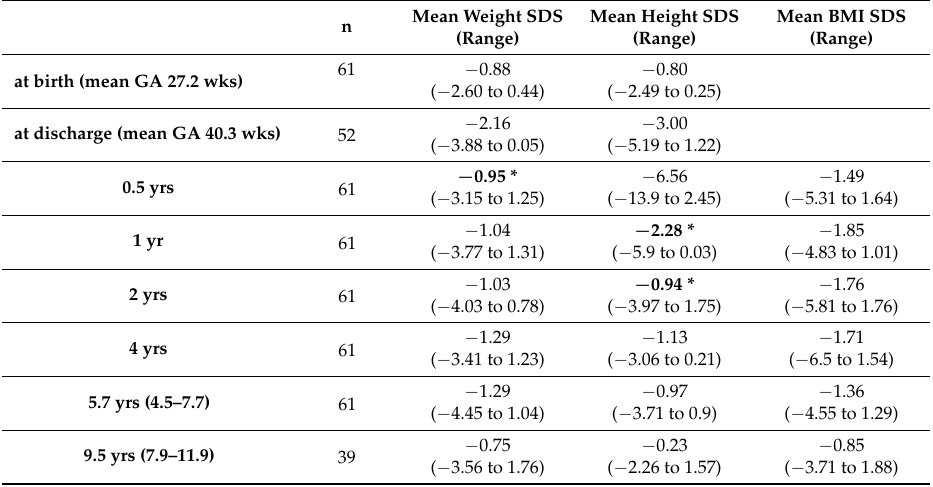
Table 1. Weight, height, and body mass index (BMI) development of ELBW subjects during follow-up. Mean Weight SDS Mean Height SDS Mean BMI SDS n (Range)